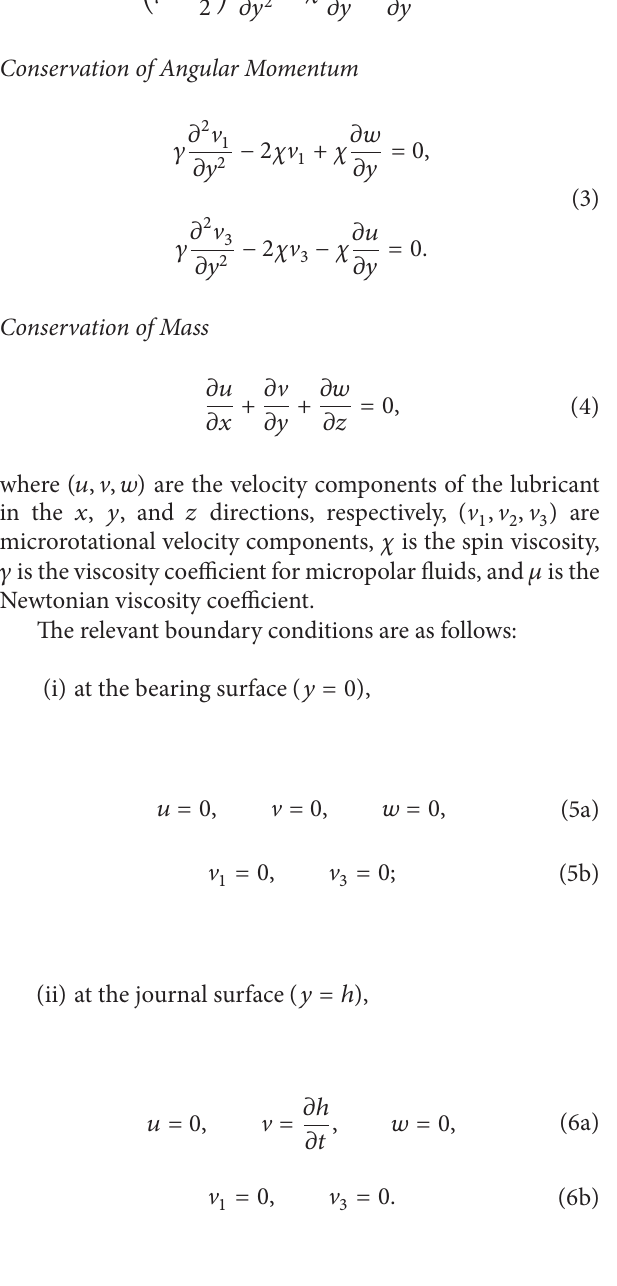
Figure 1: Squeeze film geometry of journal